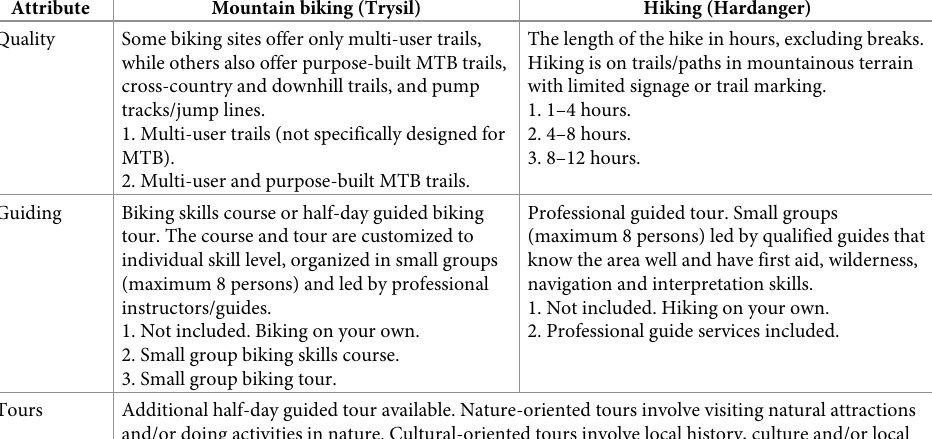
Table 2. Choice experiment attributes and levels.